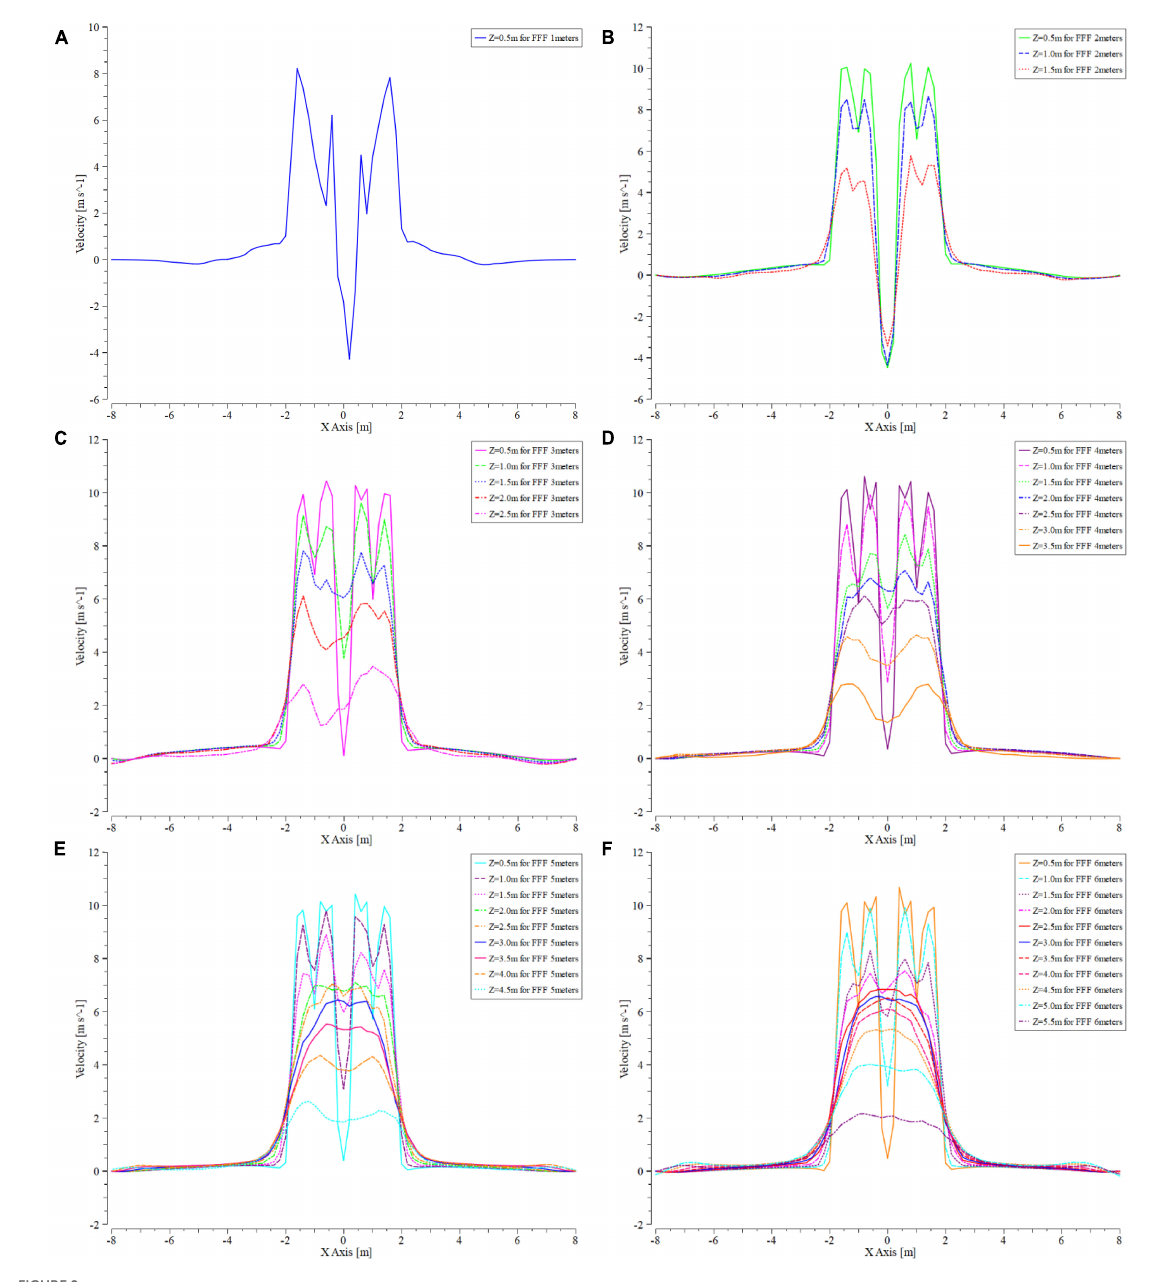
FIGURE9 Variation curve of velocity at different altitudes during simulation. (A–F) Indicate that the mUAV is flying at 1, 2, 3, 4, 5, and 6 m above the ground, respectively. The “Z” in each figure indicates the distance from below the mUAV, “for FFF meters” indicates the altitude at which the mUAV is flying. The curves in each graph indicate the wind speed of the mUAV at distance “Z,” where positive values indicate a vertical downward wash and negative values indicate a vertical upward